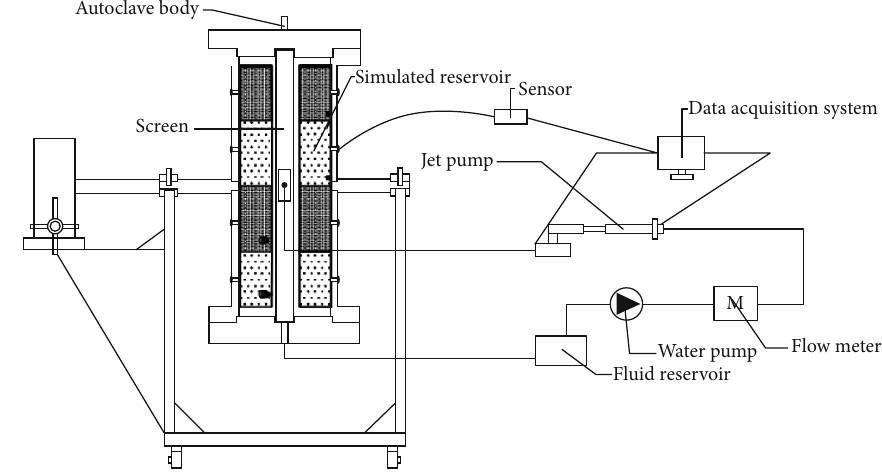
Figure 3: Illustration of the sand control experimental device.